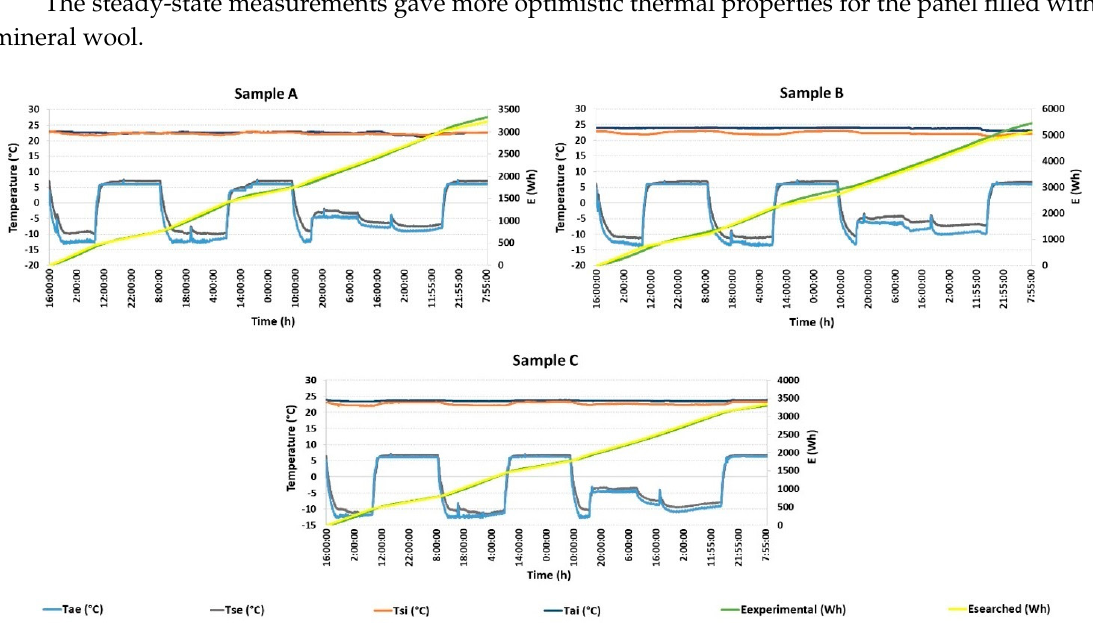
Figure 7. Total energy transmitted through the sample using searched U-value under unsteady-state conditions; ( A ) short-cut rapeseed; ( B ) short-cut woodchips; ( C ) mineral wool; T ae = air temperature in the cold chamber, T ai = air temperature in the hot chamber, T se = surface temperature of the sample in the cold chamber, T si = surface temperature of the sample in the hot chamber, Eexperimental = total energy transmitted through the sample (Wh), and Esearched = calculated total energy consumption using U-value given by Solver (Wh).